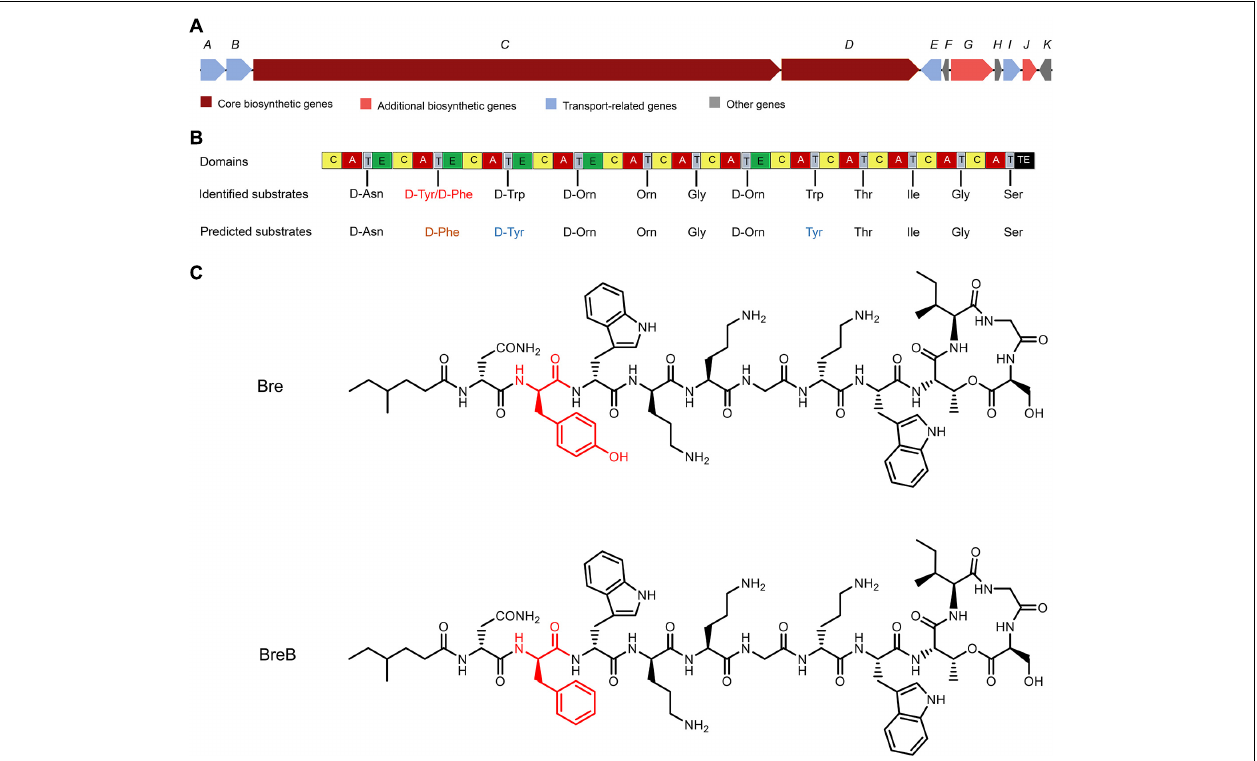
FIGURE 1 | The structures of brevicidines and the predicted biosynthetic gene cluster. (A) The non-ribosomal peptide synthetases genes harbored by the Brevibacillus laterosporus DSM 25 genome. (B) the catalytic domains encoded by the gene cluster, and the substrates incorporated by the respective modules. Domains: A, adenylation; T, thiolation; C, condensation; E, epimerization; TE, thioesterase. (C) structures of brevicidines. The red color indicates the different structure of